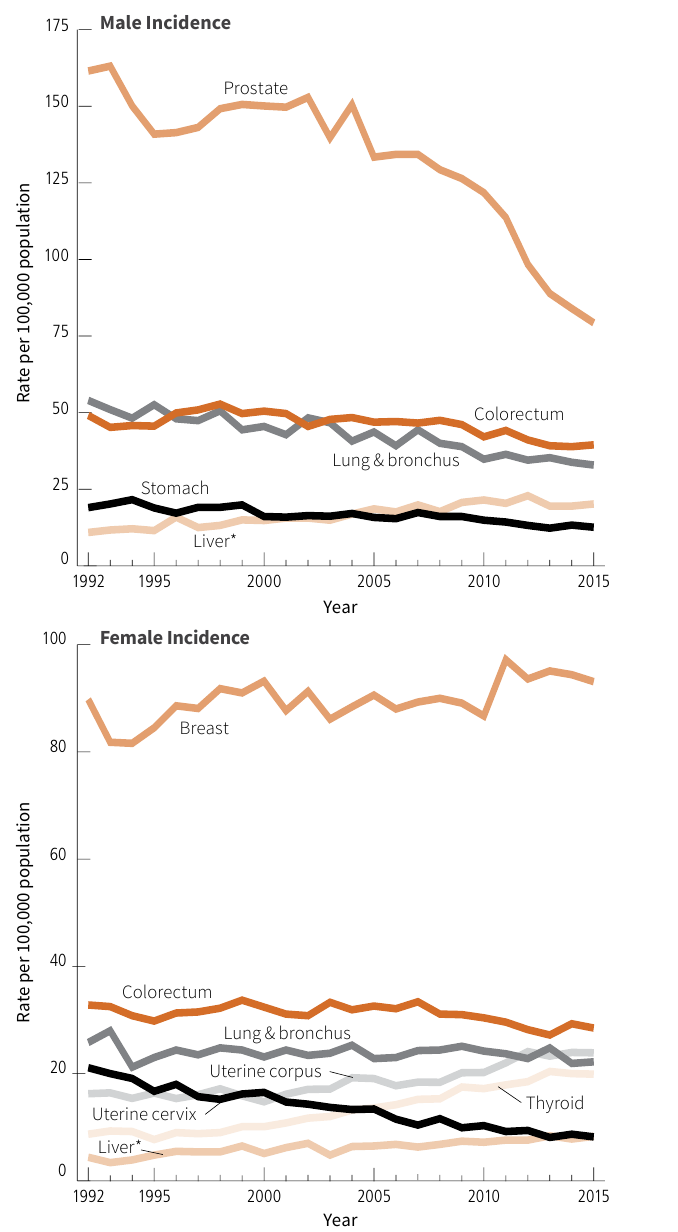
Figure 4. Trends in Incidence and Death Rates among Hispanics for Selected Cancers, US, 1990-2016 Male